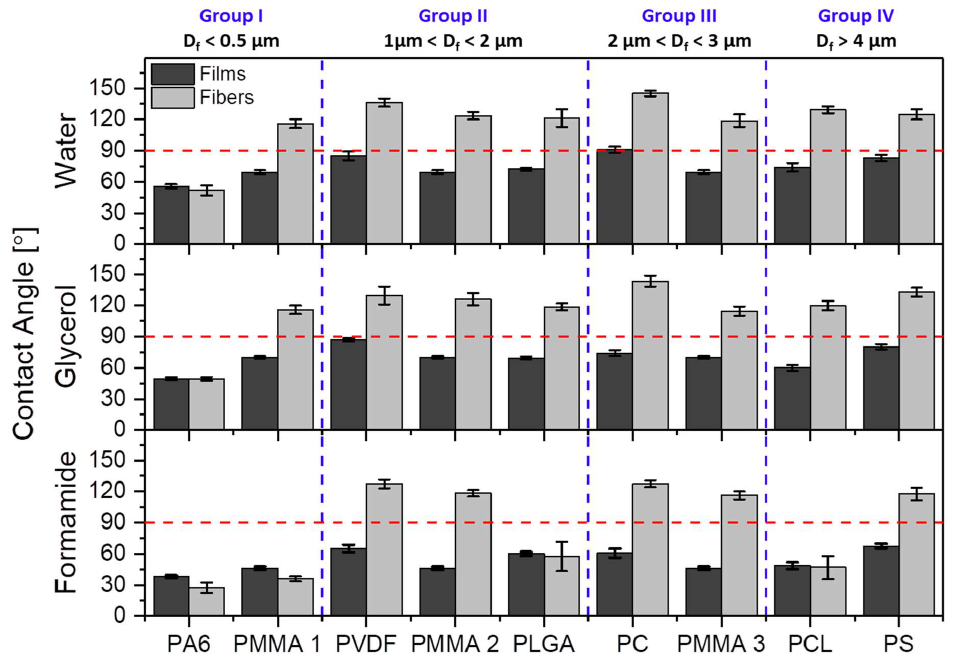
Figure 3. Contact angles values on polymer films and meshes for water, glycerol, and formamide. The horizontal red dashed lines indicate the threshold contact angle of 90° between hydrophobic and hydrophilic properties and perpendicular blue dashed lines indicate the four groups according to the average fiber diameter, D f .